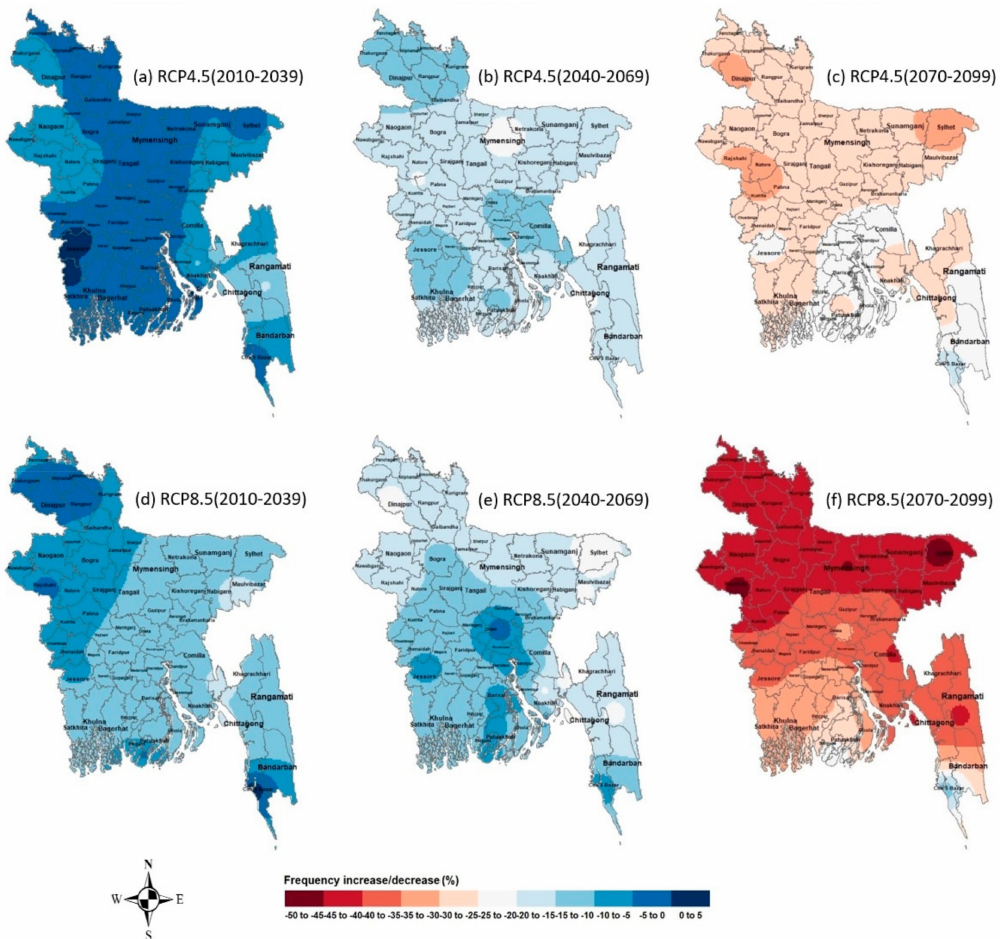
Figure 8. Percentage (%) change in the drought frequency over Bangladesh for the 2010s (1st column), 2040s (2nd column), and 2070s (3rd column) under the RCP4.5 (upper row) and RCP8.5 (lower row) scenarios relative to the baseline period